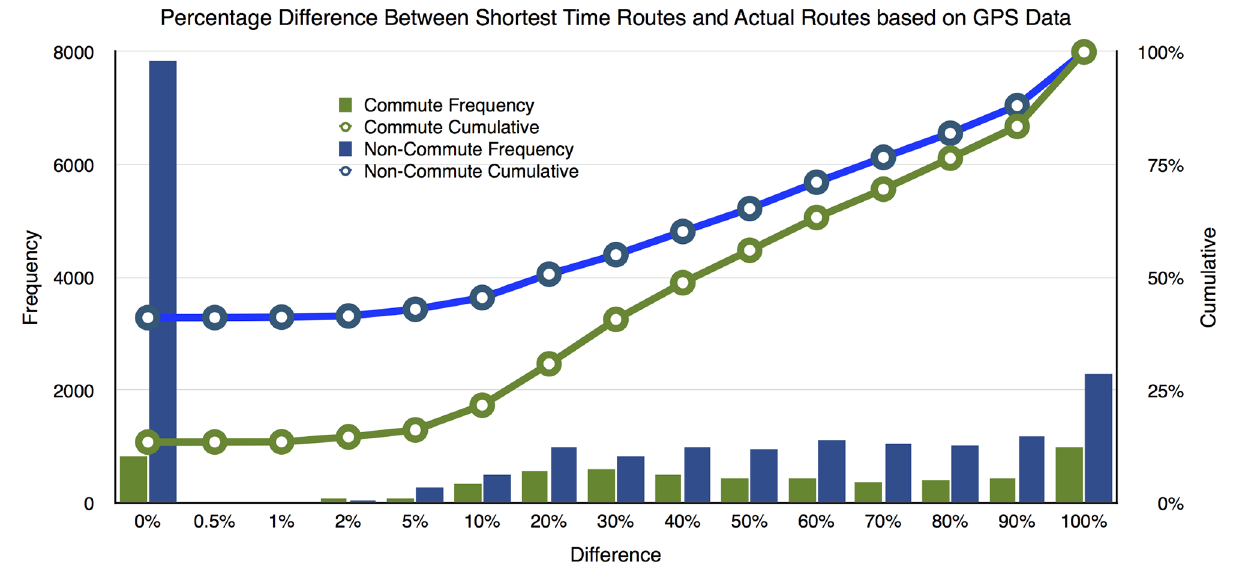
Fig 1. Difference between GPS-revealed route and the shortest time route between the same OD.